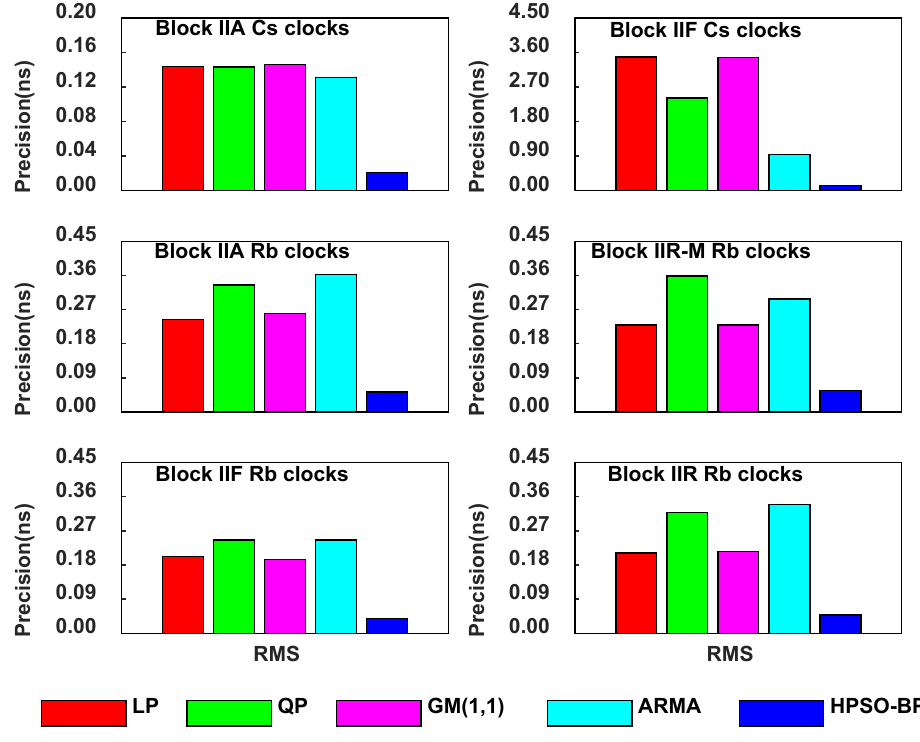
Figure 7. Prediction precision bar chart for six types of satellite clocks in 60 min for 13 September